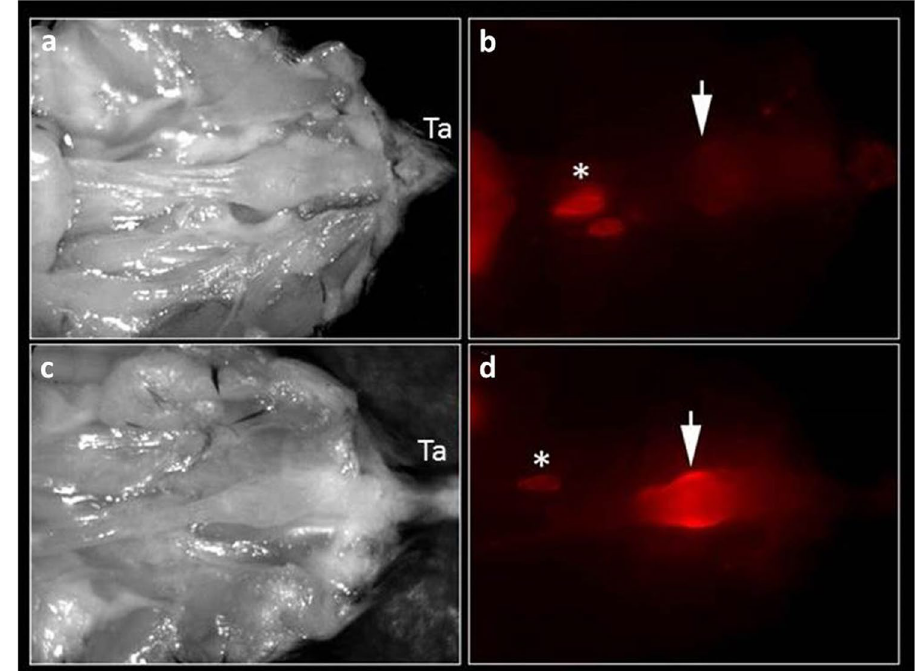
Figure 2. Tumor imaging with liposomal ICG (Lip-ICG) at 60 nm. The mice underwent a median laparotomy during which the urine bladder and genitalia were resected in order to expose the rectum; Ta, tail. ( a , b ) Free ICG; ( c , d ) Lip-ICG. The arrows indicate the tumor, and the asterisks indicate draining peri-caval lymph nodes. Shown is one representative mouse from each group, out of three experiments, n = 12 for free ICG and n = 20 for Lip-ICG. The signal intensity was determined 12 hours after i.v. injection.